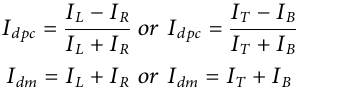
dark- fi eld imaging. The ring source consists of 32 green LEDs with a central wavelength of 531 nm and a line-width of about 30 nm . In order to generate an asymmetric illumination pattern, the LED ring is divided into 4 groups, with each group having eight LEDs. The adjacent two groups are used to form top and bottom or left and right illumination patterns as shown in Figure 1B . If the worm body is largely horizontal in the fi eld of view, we will use horizontally asymmetrical illumination scheme. Otherwise, we will use vertically asymmetric scheme.